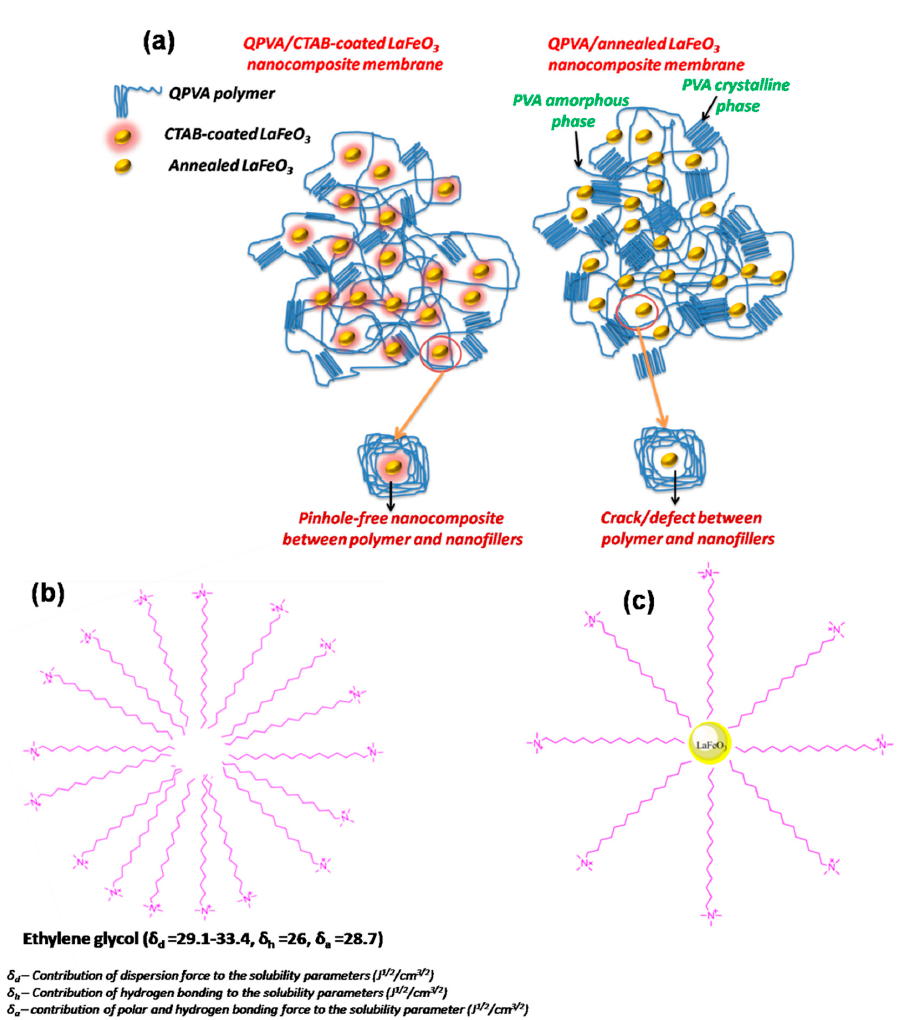
Figure 6. Schematic illustrations of: ( a ) the structures of QPVA/CTAB-coated LaFeO 3 and QPVA/annealed LaFeO 3 nanocomposite membranes; ( b ) CTAB micelle dispersed in polar ethylene